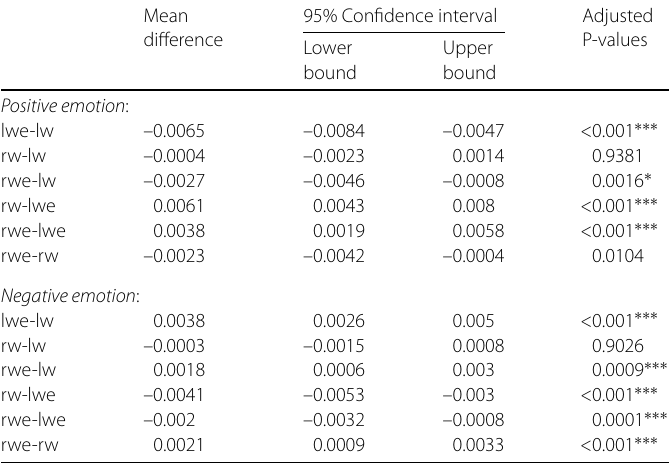
Table 11 Multi-group mean comparisons of positive and negative emotions using Tukey’s HSD test Mean 95% Confidence interval Adjusted difference P-valuesLower Upper bound bound Positiveemotion : lwe-lw –0.0065 –0.0084 –0.0047 <0.001 ∗∗∗ rw-lw –0.0004 –0.0023 0.0014 0.9381 rwe-lw –0.0027 –0.0046 –0.0008 0.0016 ∗ rw-lwe 0.0061 0.0043 0.008 <0.001 ∗∗∗ rwe-lwe 0.0038 0.0019 0.0058 <0.001 ∗∗∗ rwe-rw –0.0023 –0.0042 –0.0004 0.0104 Negativeemotion : lwe-lw 0.0038 0.0026 0.005 <0.001 ∗∗∗ rw-lw –0.0003 –0.0015 0.0008 0.0018 0.0006 0.003 rw-lwe –0.0041 –0.0053 –0.003 rwe-lwe <0.001